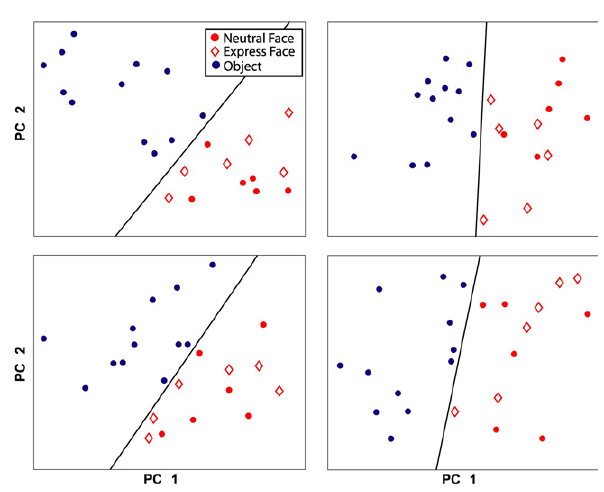
Figure 5. Principal component analysis of the response to each exem- plar. Each plot shows the results from one electrode site in auditory cortex. For each site, the fi rst two principal components of the responses are dis- played. A black line separates face (red) from object (blue) exemplars. Within the face category, expression exemplars (diamonds) are not separable from neutral exemplars (fi lled